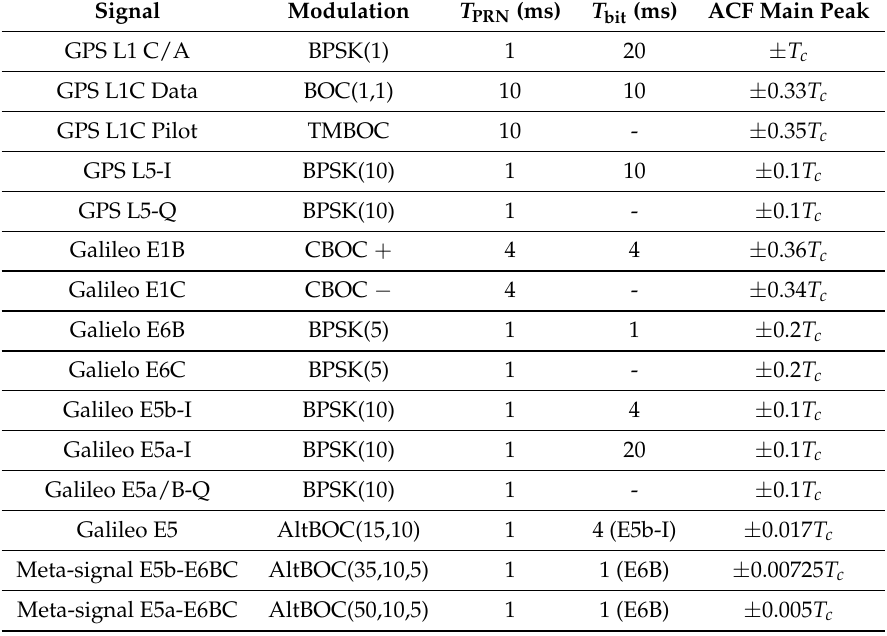
Table 1. GPS, Galileo, and meta-signals main characteristics. T c is defined as the GPS L1 C/A chip period, i.e., 1.023 × 10 − 6 s, and ACF main peak refers to the first zero-crossing of the